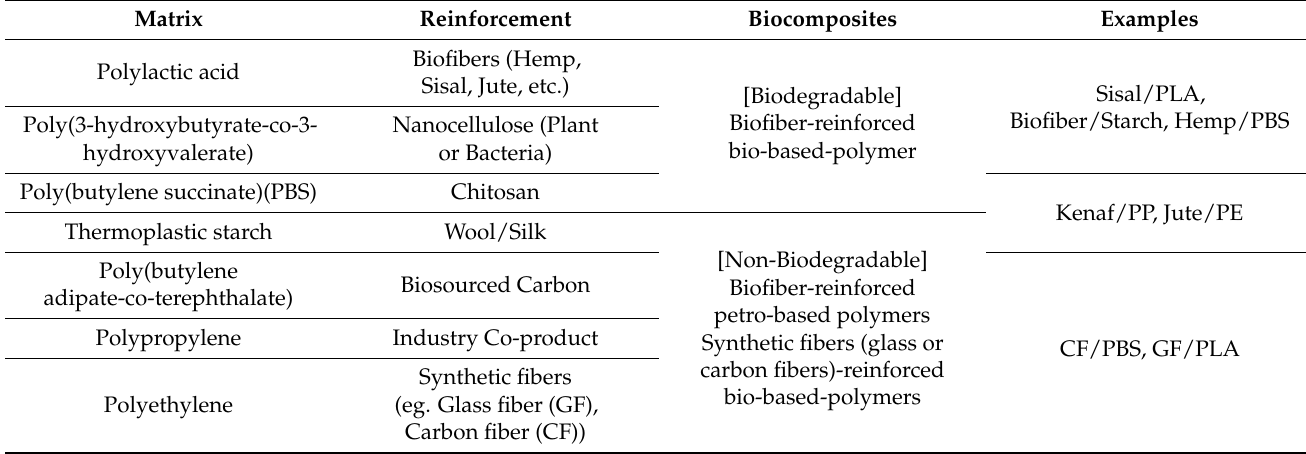
Table 3. Examples of potential hybrid and reinforcement materials for common composites as well as biocomposites [30]. Matrix